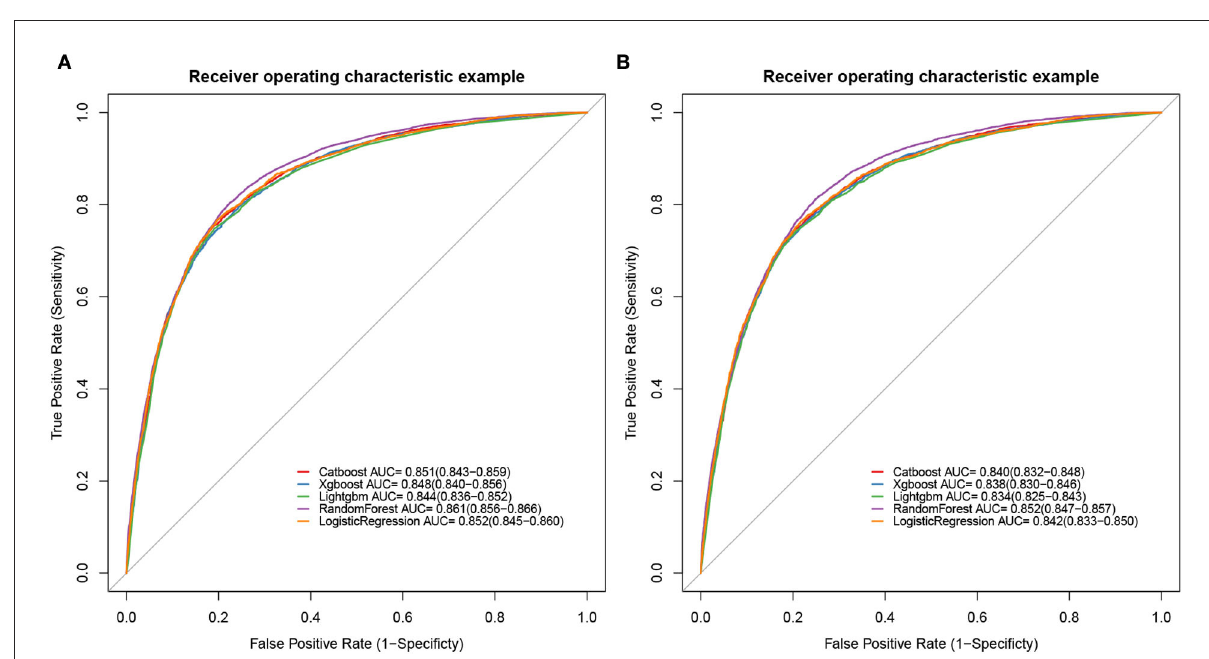
FIGURE6 ROC curves of ML models. Overall early death (A) and cancer-specific early death (B)